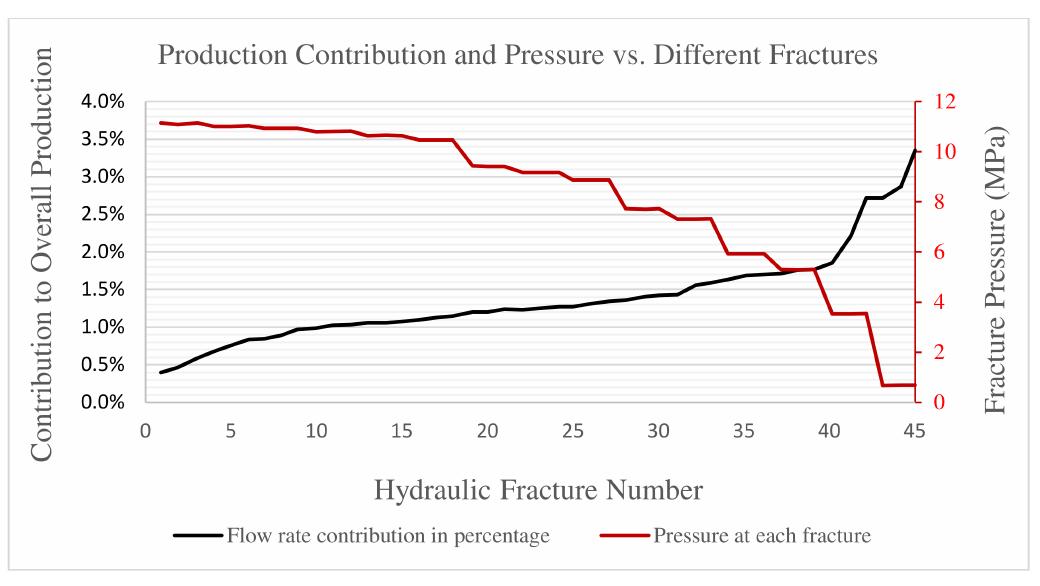
Figure 14. Pressure distribution and production contribution at each hydraulic fracture in the tilt-up well case.